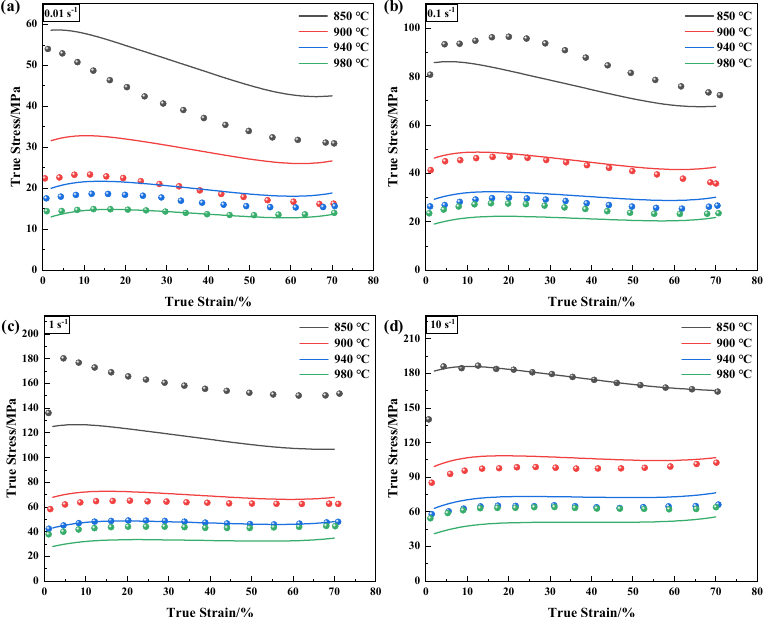
Figure 7. The comparison between the experimental data and predicted data of the Arrhenius-type model at different strain rates: ( a ) 0.01 s − 1 ; ( b ) 0.1 s − 1 ; ( c ) 1 s − 1 ; and ( d ) 10 s − 1 .